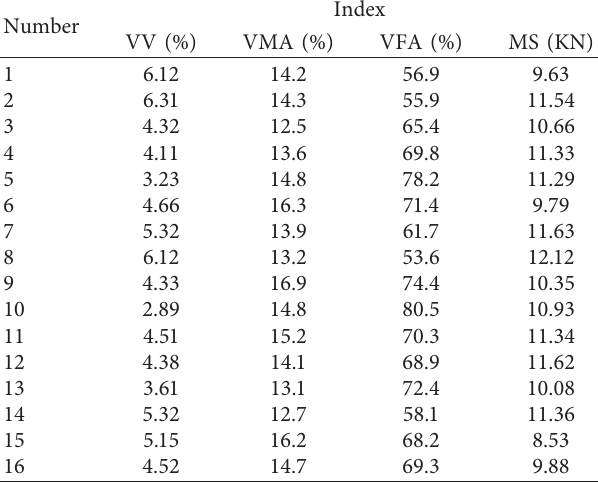
Table 9: Marshall test results of LASTIKA-13 orthogonal schemes. Table 8: Scheme of LASTIKA-13 gradation orthogonal Test.